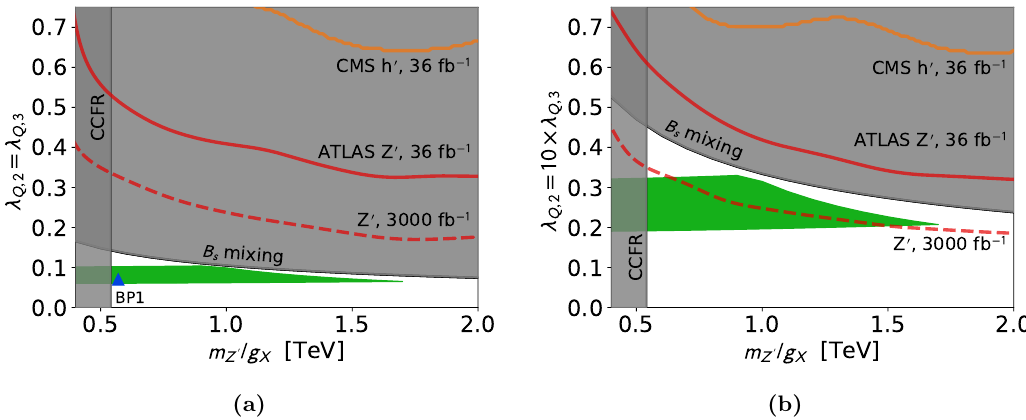
Figure 8. Bounds from B s -mixing (gray area is excluded) and neutrino trident production (dark gray area is excluded). Upper exclusion bound from current ATLAS [97] dilepton search (red line), our HL-LHC projection for the same analysis (dashed red line), di- Z search from h 0 decay (orange line) and the region favored by the R anomalies (green area), in the (cid:21) Q; 2 and m Z 0 =g X plane for K ( (cid:3) ) the ratios (a) (cid:21) Q; 2 = (cid:21) Q; 3 , (b) and (cid:21) Q; 2 = 10 (cid:2) (cid:21) Q; 3 . All other parameters are chosen according to benchmark point BP1 (blue star) as presented in tables 1 and